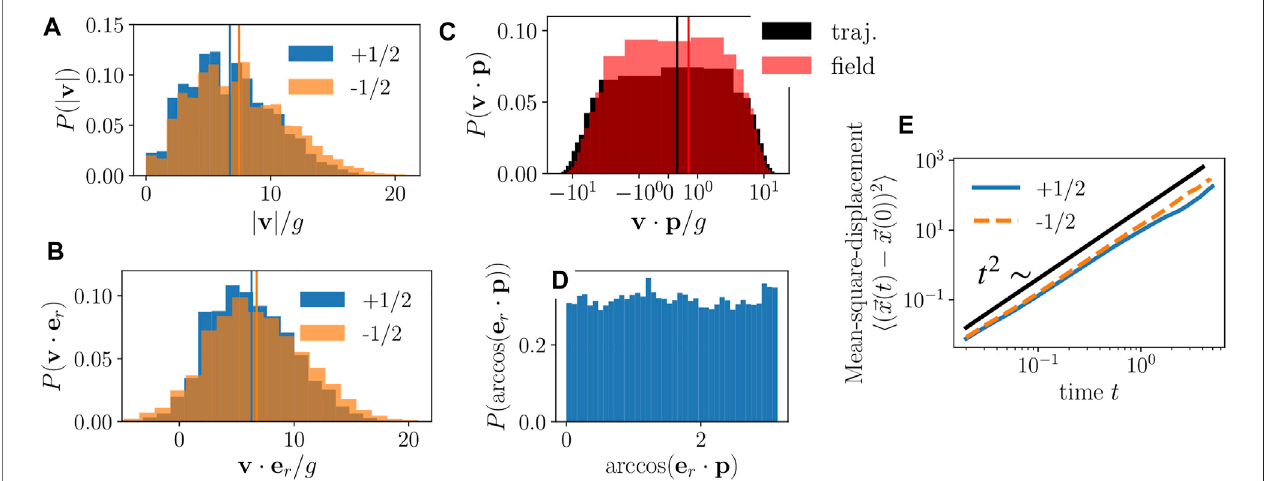
FIGURE 4 | (A, B) Distributions of speeds (A) and radial component of velocity (B) of +1/2 (blue) and − 1/2 (orange) defects. Vertical lines show mean of each distribution. (C) Distributionofvelocityprojectedontoheadingdirectionof+1/2defects.Forblackbarsthevelocitywasextractedfromthedefecttrajectorieswhileforthe red bars the velocity was extracted from the fl ow fi eld. Lines show the mean of the respective distributions. (D) Distribution of heading direction of +1/2 defects with respect to the radially outward unit vector from the colony ’ s center of mass. (E) Mean-square displacements of +1/2 (blue solid line) and − 1/2 (orange dashed line) defects. Black line shows a t 2 scaling. We used an aspect ratio of l 0 / d 0 = 10 and averaged over defect trajectories from 10 independent simulation runs.